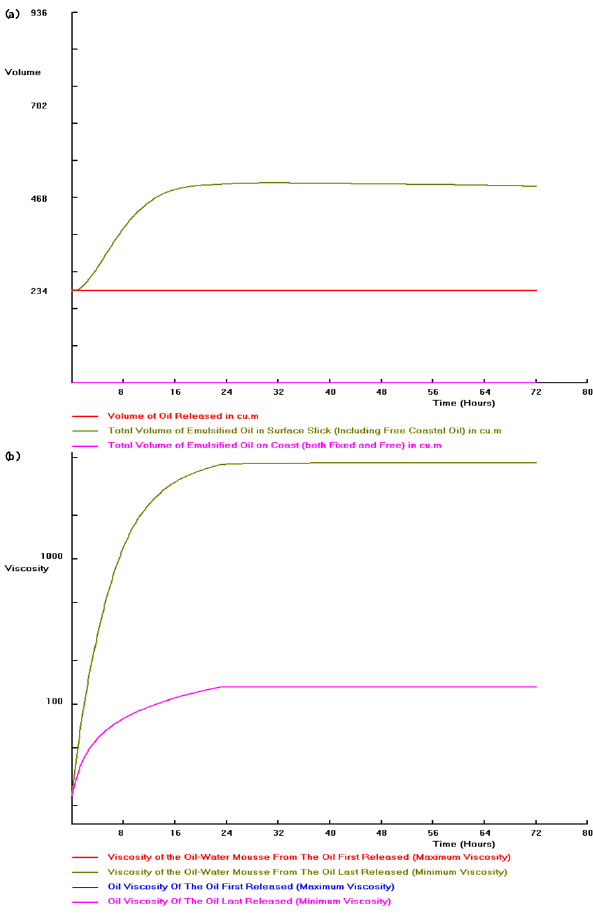
Fig. 7. (a) Estimated volume released and volume of floating mousse. (b) Estimated viscosities of the oil and mousse.